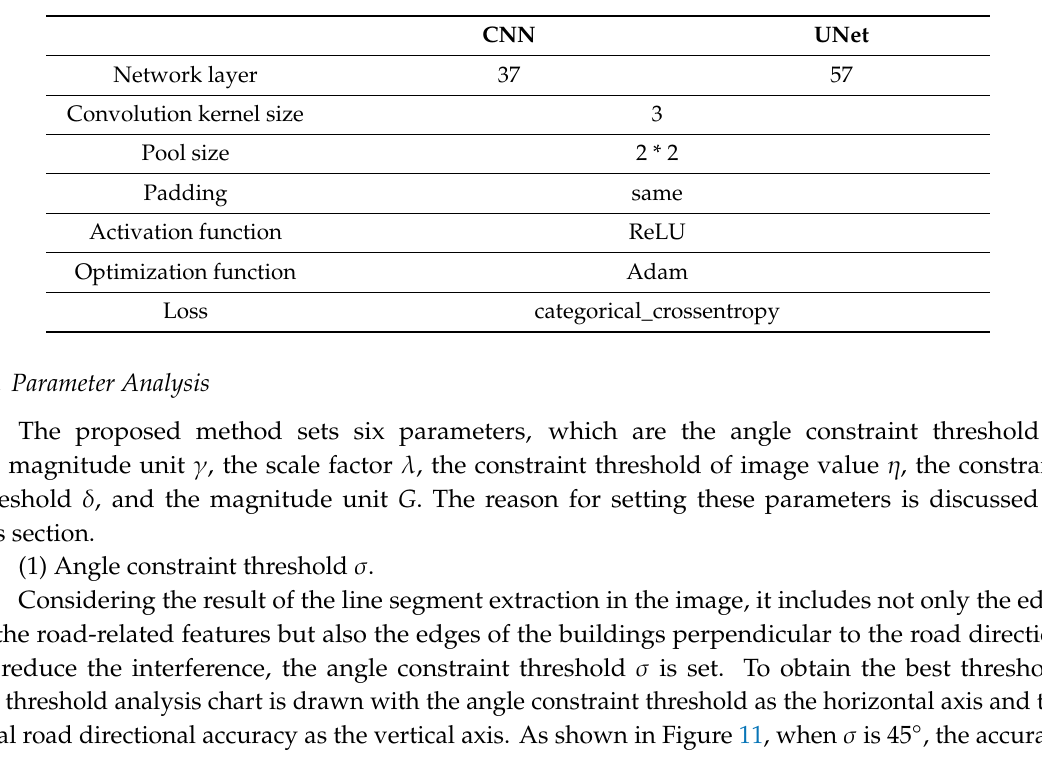
Table 1. Comparison method parameter setting